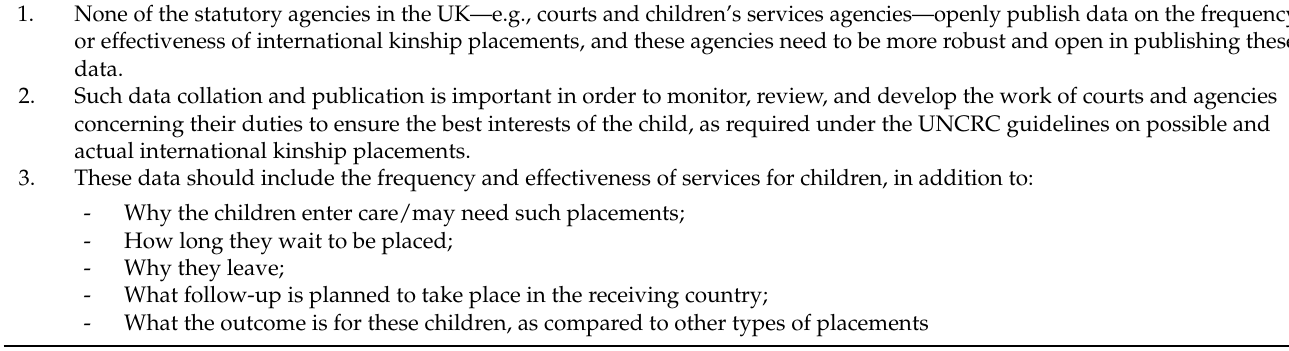
Table 4. Importance of information and